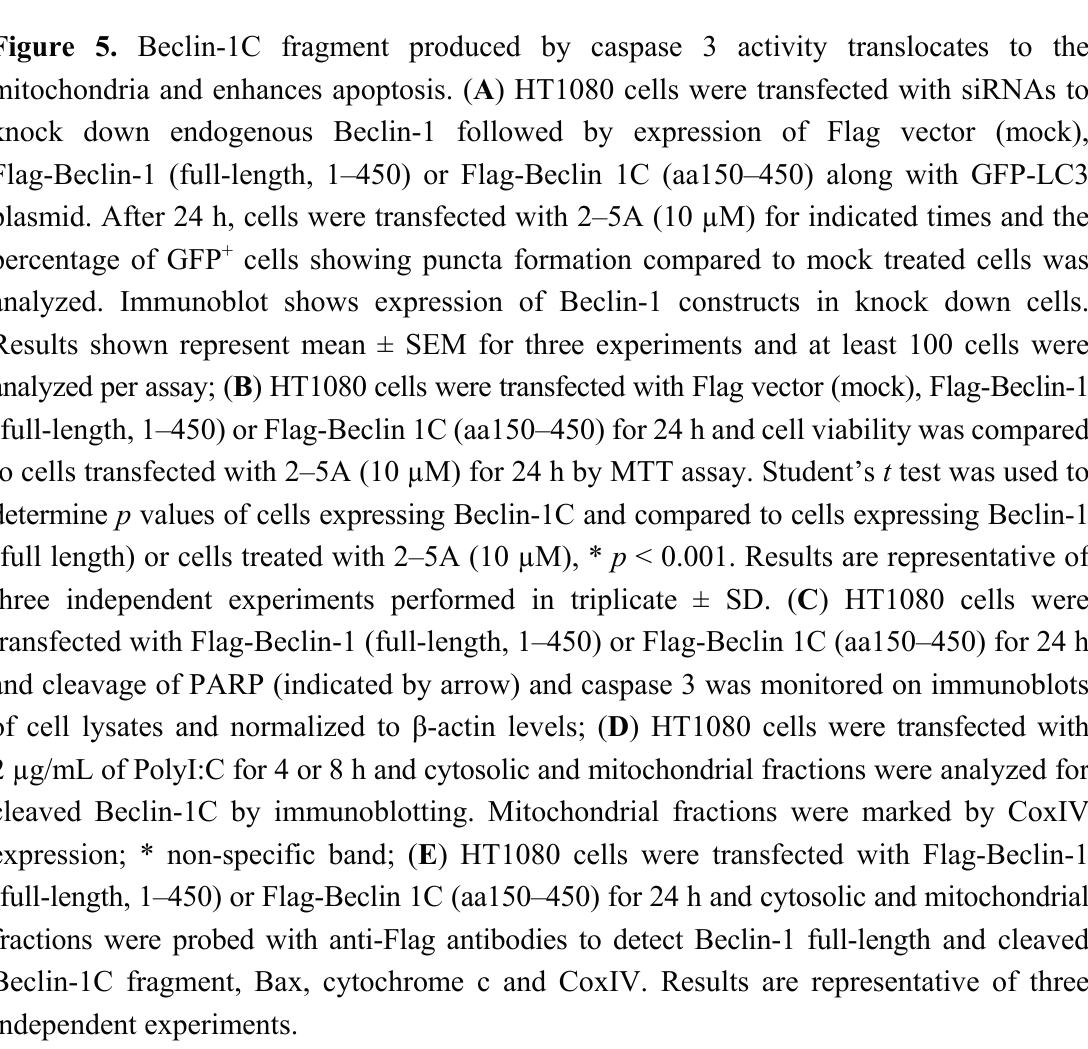
(full-length, 1–450) or Flag-Beclin 1C (aa150–450) for 24 h and cytosolic and mitochondrial fractions were probed with anti-Flag antibodies to detect Beclin-1 full-length and cleaved Beclin-1C fragment, Bax, cytochrome c and CoxIV. Results are representative of three independent